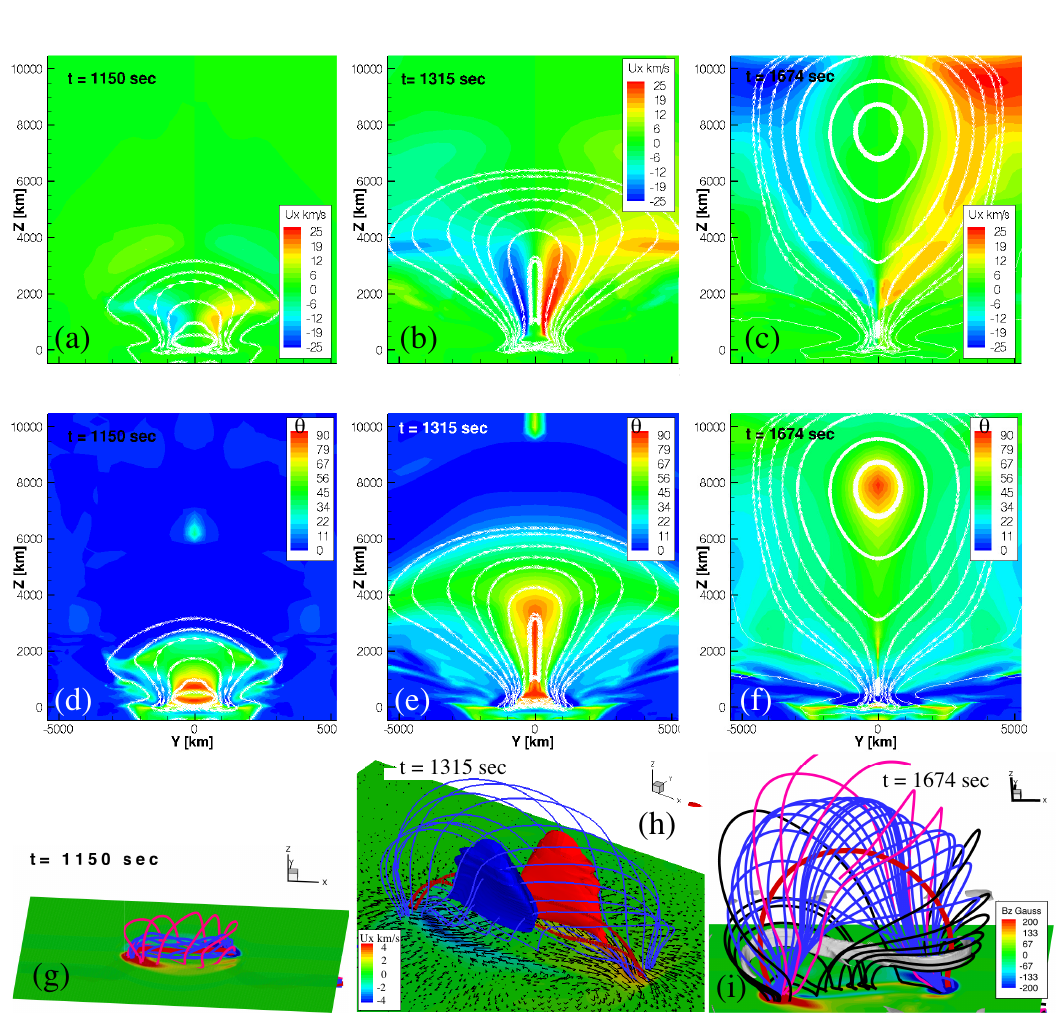
Figure 42: Numerical simulation of the evolution of magnetic field from twisted flux rope emergence. Panels (a)–(f) show a vertical plane normal to the axis of the initial submerged tube. The direction of the magnetic field in the plane is depicted with solid white lines. Panels (a)–(c) show the velocity 𝑈 𝑥 (out of the plane), while panels (d)–(f) show color images of the shear angle measured in degrees. Panels (g)–(i) show 3D visualizations of magnetic field lines and the vertical field strength 𝐵 𝑧 at the photosphere. Panel (h) shows 𝑈 𝑥 at the photospheric level along with arrows indicating the flow velocity. Isosurfaces of 𝑈 𝑥 are shown colored in blue (–19 km s –1 ) and red (+19 km s –1 ). Image adapted from Manchester IV et al. (2004), courtesy of W.